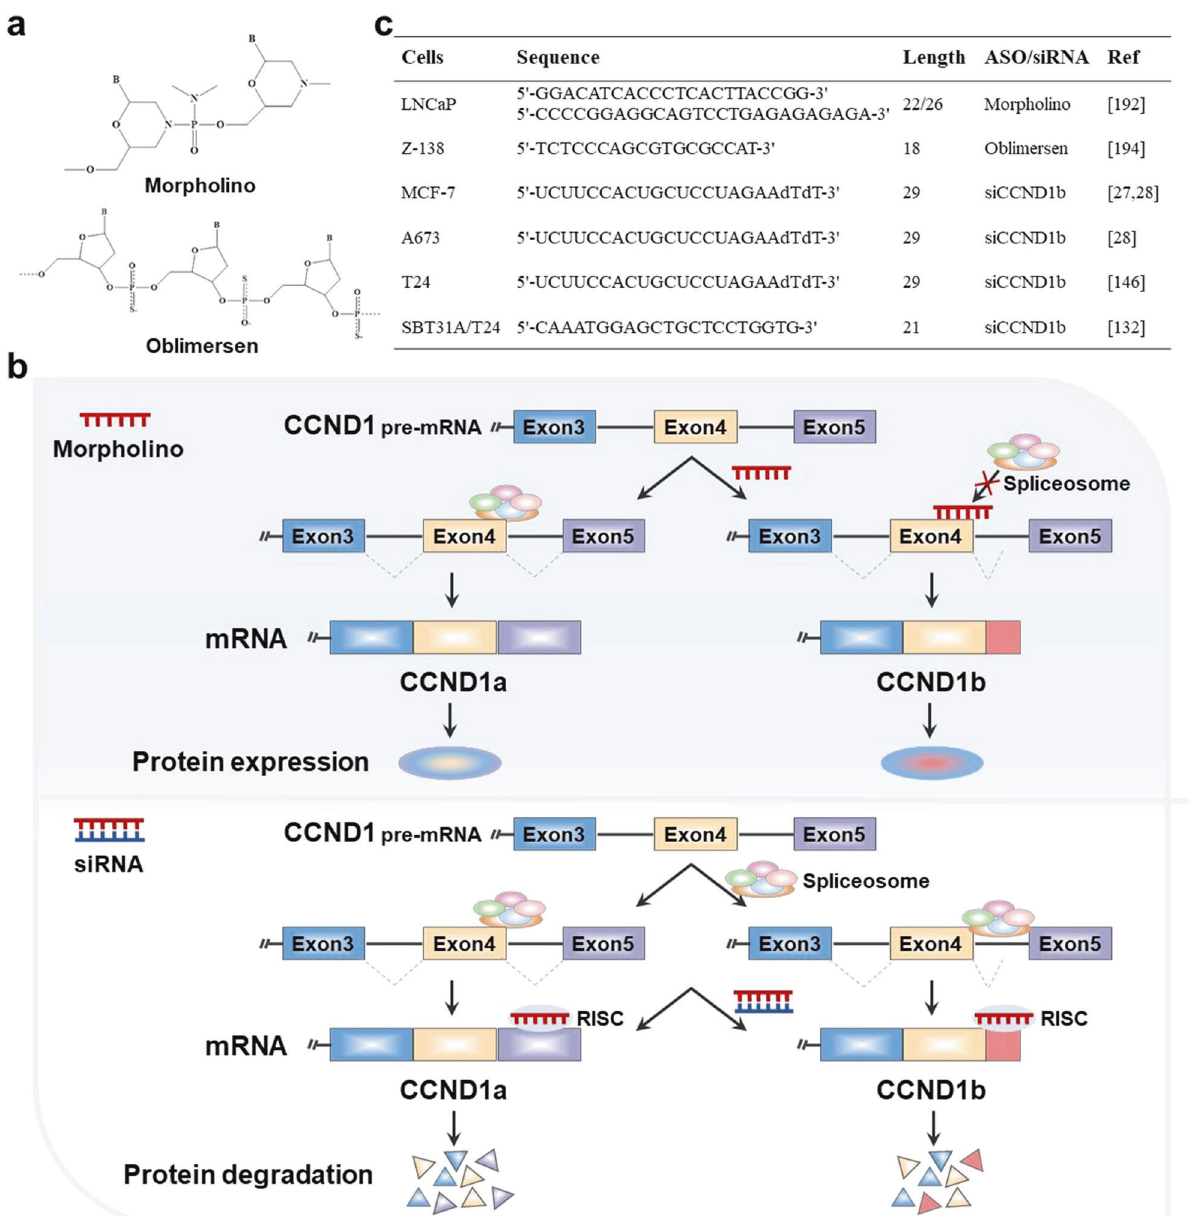
Fig. 6 Strategies modulating CCND1 isoforms in cancer. a Chemical formulae of morpholino and oblimersen. b Morpholino that binds to the exon 4/intron 4 boundary prevents the binding of spliceosome, resulting in a splicing shift to the short isoform CCND1b. siRNA targeting CCND1 isoforms can down-regulate the expression of CCND1 isoforms by binding to the mRNA of target gene. c Sequences of ASO and siRNA used to modulate CCND1